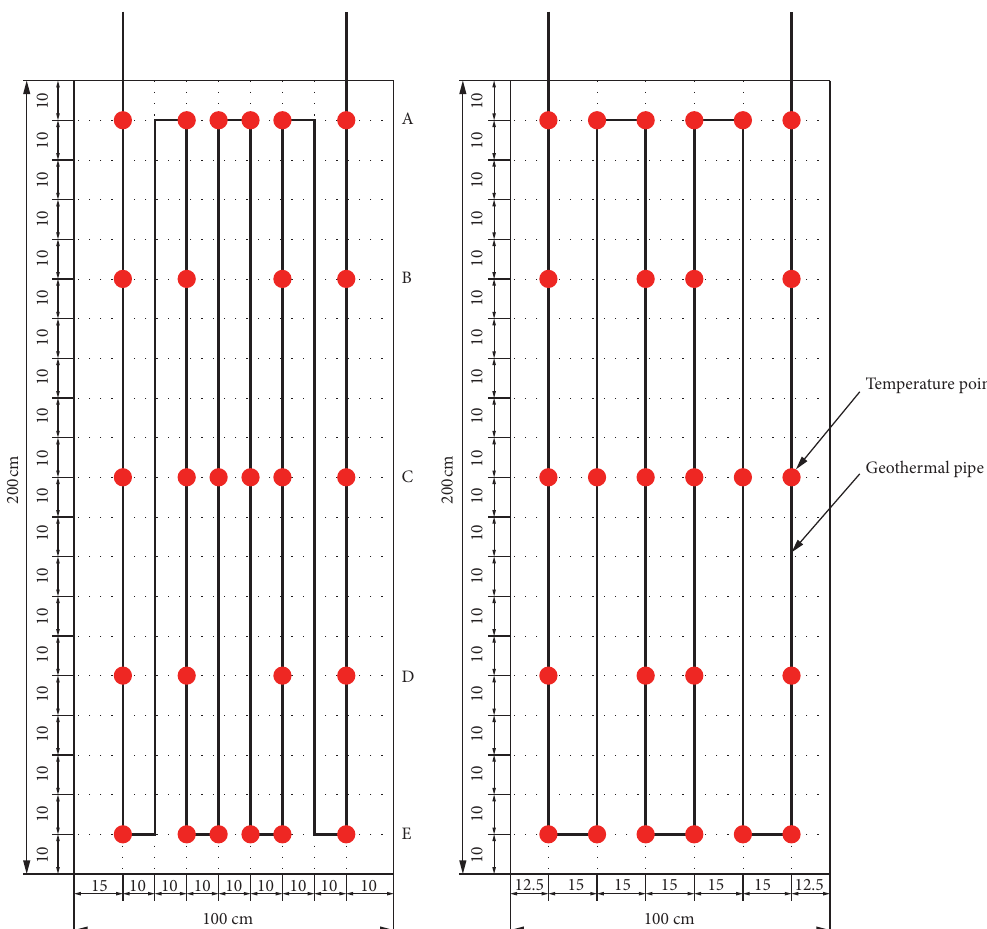
Figure 2: Geothermal pipe space and measurement points